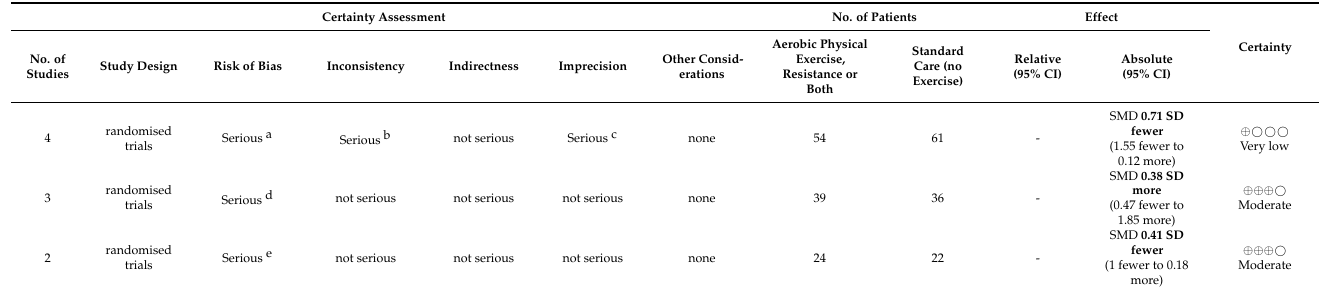
Table 2. Quality of evidence for the body composition, BMI, FM% and FFM Kg.